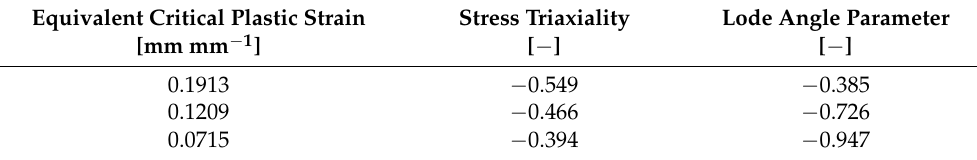
Table 2. Equivalent critical plastic strain and Lode angle parameter variation with stress triaxiality for the notched cylindrical